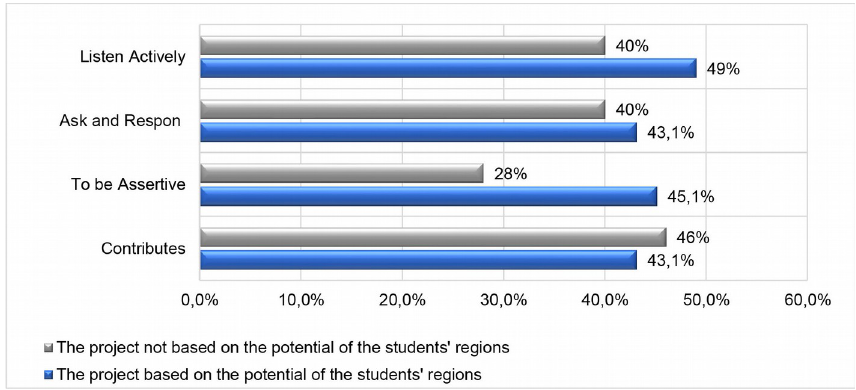
Figure 3. The comparison on students’ perception of teamwork